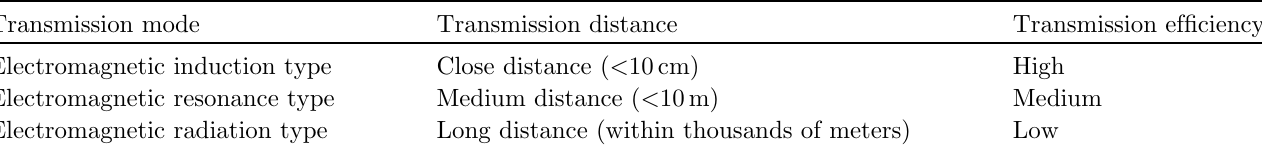
Table 1. Three modes of WPT system transmission.